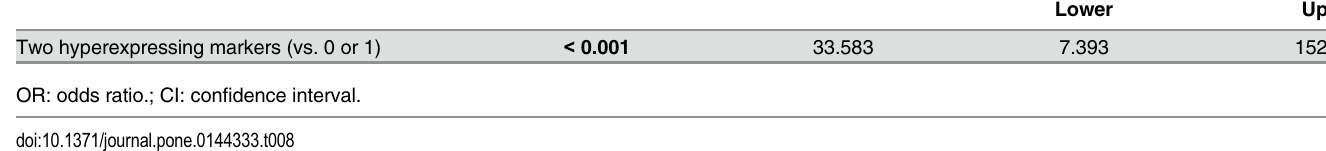
Table 8. Logistic regression using the combined risk score (hyperexpression of ITGAV and ITGA6 – 0 or 1 hyperexpressing marker versus 2 hyper- expressing markers) as an independent variable and TNM as a dependent variable. TNM